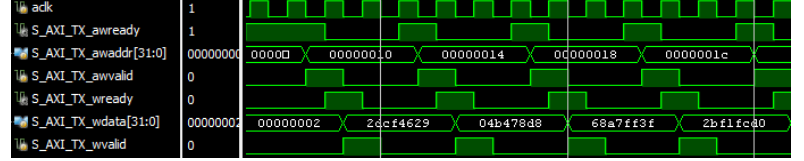
Fig. 5. The transmitted OFDM payload (one data symbol)